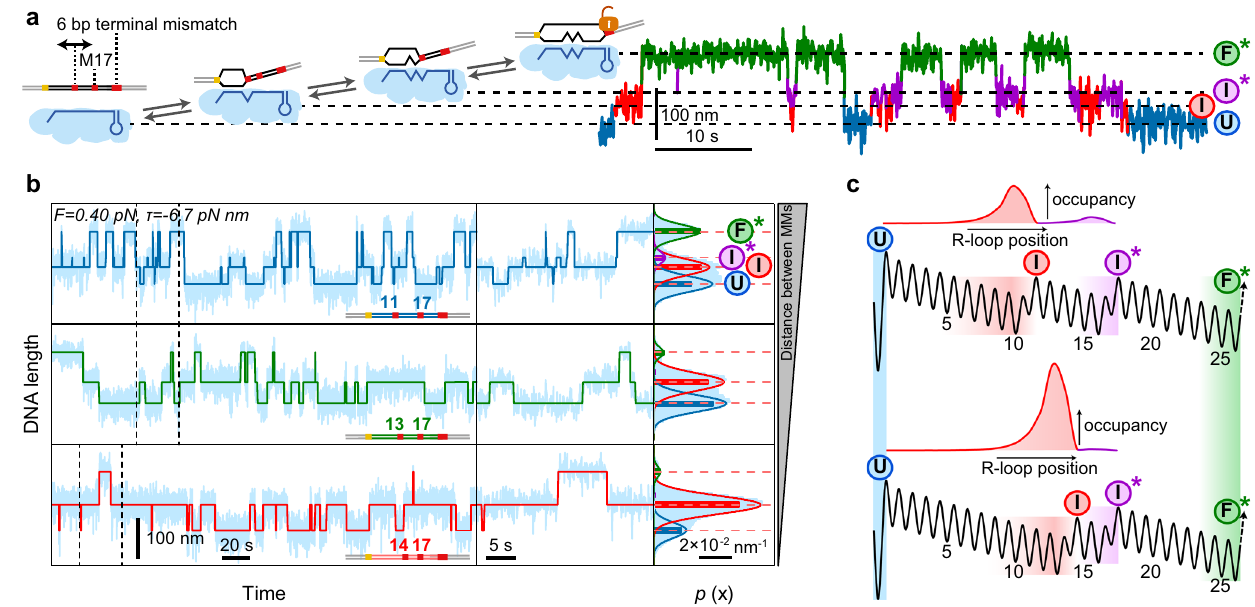
Fig. 5 | R-loop dynamics on locking-de fi cient targets containing two internal mismatches. a Sketch of the DNA construct with mismatched bases shown in red and the possible R-loop states: the unbound state ( U ), two intermediate R-loops ( I beforethe fi rstand I * beforethesecondmismatch)andthealmostfullbutunlocked R-loop ( F * ). Sequential transitions between these states can be described by six different rates. Example trajectory of the transitions between the different states measured for a C:C mismatches. b Trajectories and histograms of the DNA length recorded for targets containing C:C mismatches with varying proximities at a tor- que of − 6.7pNnm (light blue). Four-state and three-state (in case I and I * states